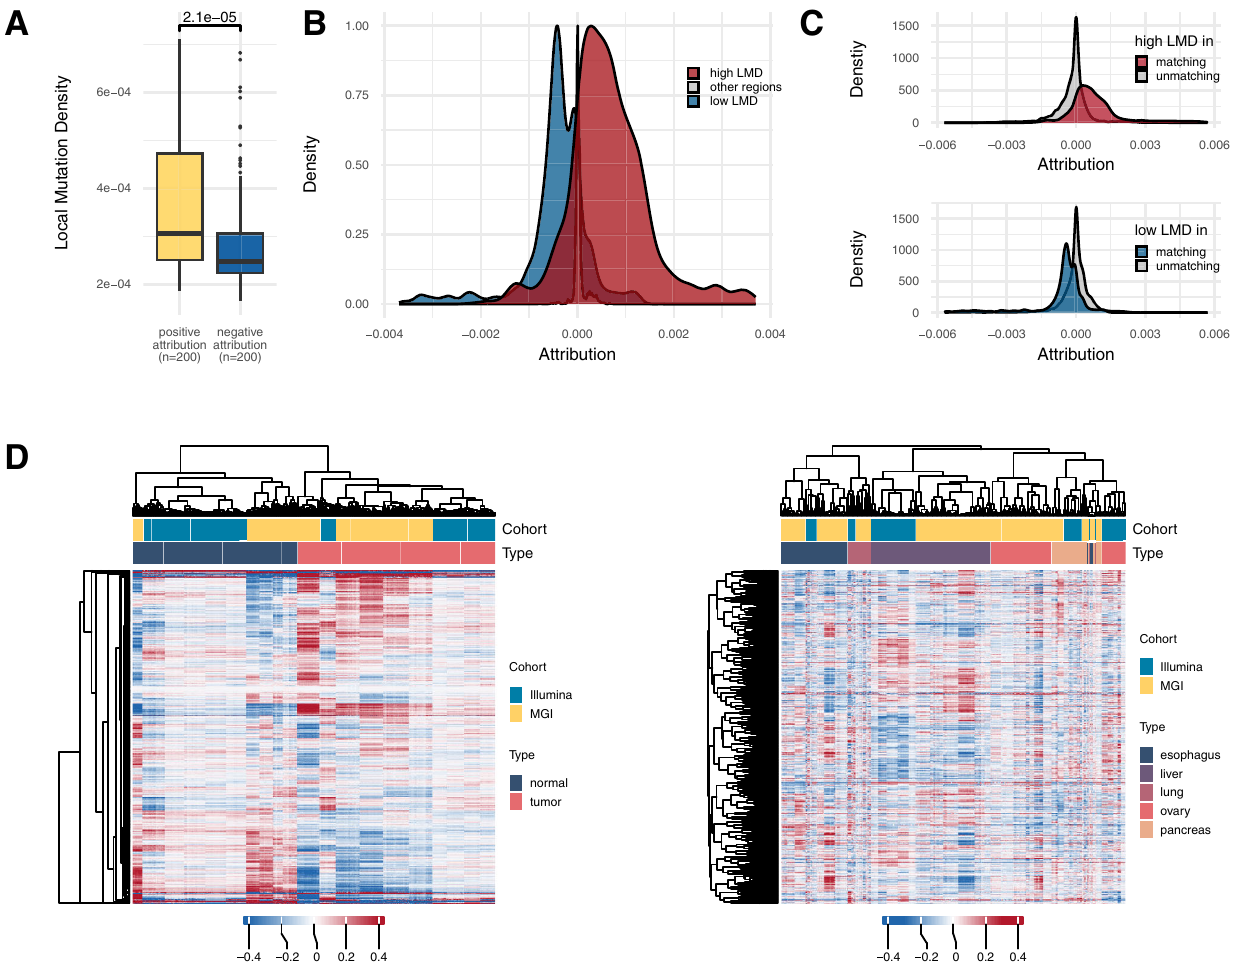
Fig. 5 | Interpretation ofthe genome model. A LMD values obtainedfrom tumor tissues in the LVD regions with positive or negative attribution for cancer samples in the genome model for cancer detection on the MGI training cohort. P values from the Wilcoxon test are indicated (two-sided). Each box indicates IQR and median, whiskers indicates 1.5× IQR, black dots indicates outlier. B Distribution of theattributionvaluesassignedbythecancerlocalizationgenomemodeloftheMGI training cohort to high or low LMD regions in comparison to other regions of the PCAWG cancer type matching the given prediction label. C Comparison of the attribution values assigned by the cancer localization genome model to high